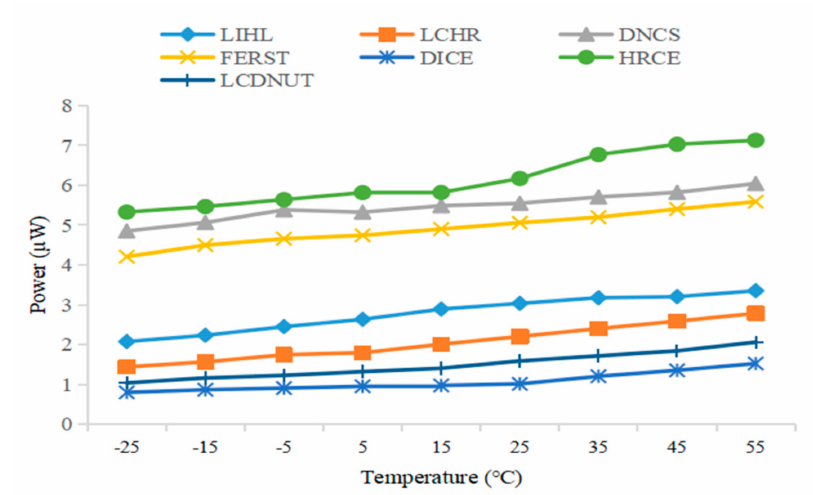
Figure 19. Power consumption of various latch designs under different temperatures.